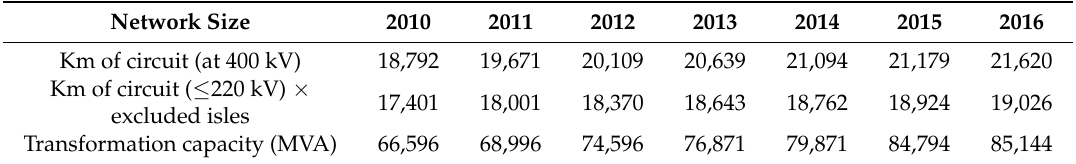
Table 2. Evolution of the Spanish transmission and transformation power system